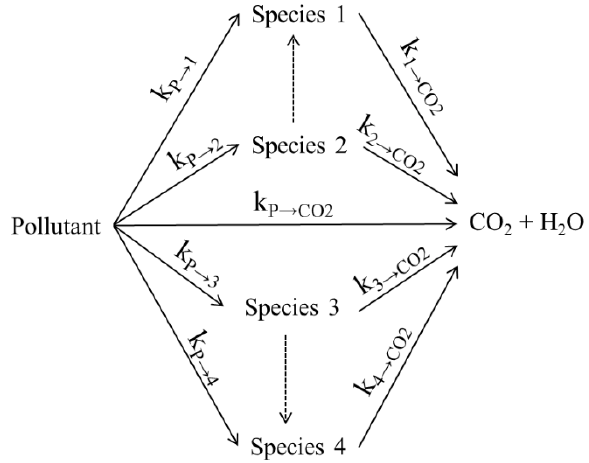
Figure 12. Description of the “parallel-series” reaction network for the photodegradation of organic pollutants based on “observable” intermediate species and CO 2 . Note: “ k i “ denotes the kinetic constant for each individual reaction step [3]; and the term “Species” refers to intermediate oxygenated species formed during model pollutant conversion.